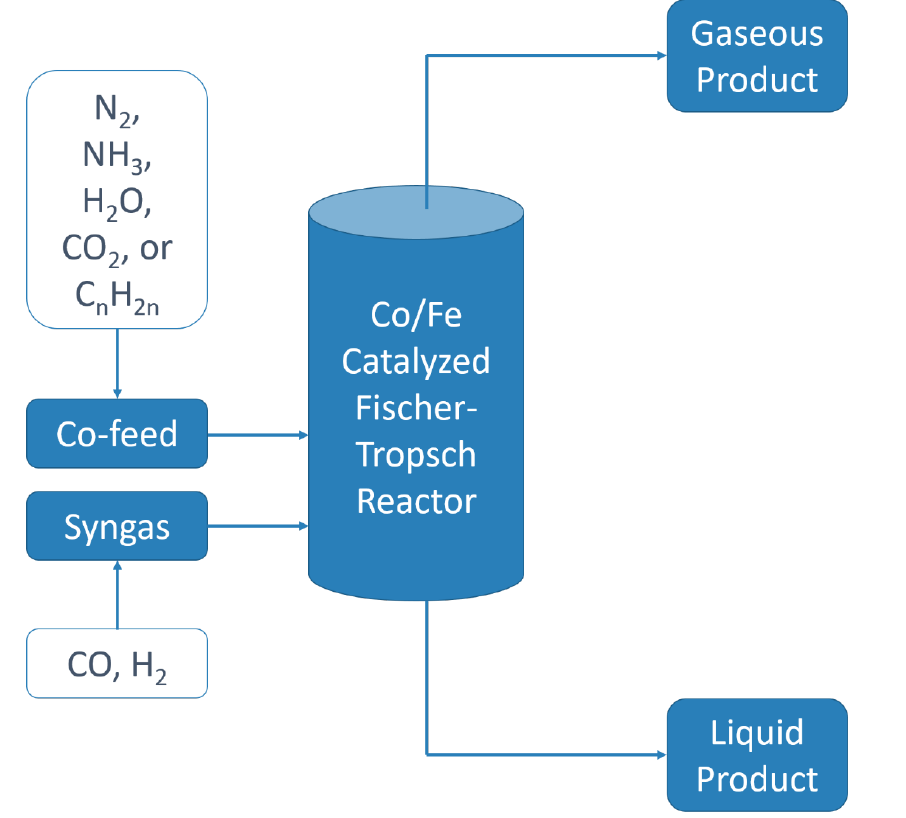
Figure 1. Illustration of co-feeding components considered in this review.